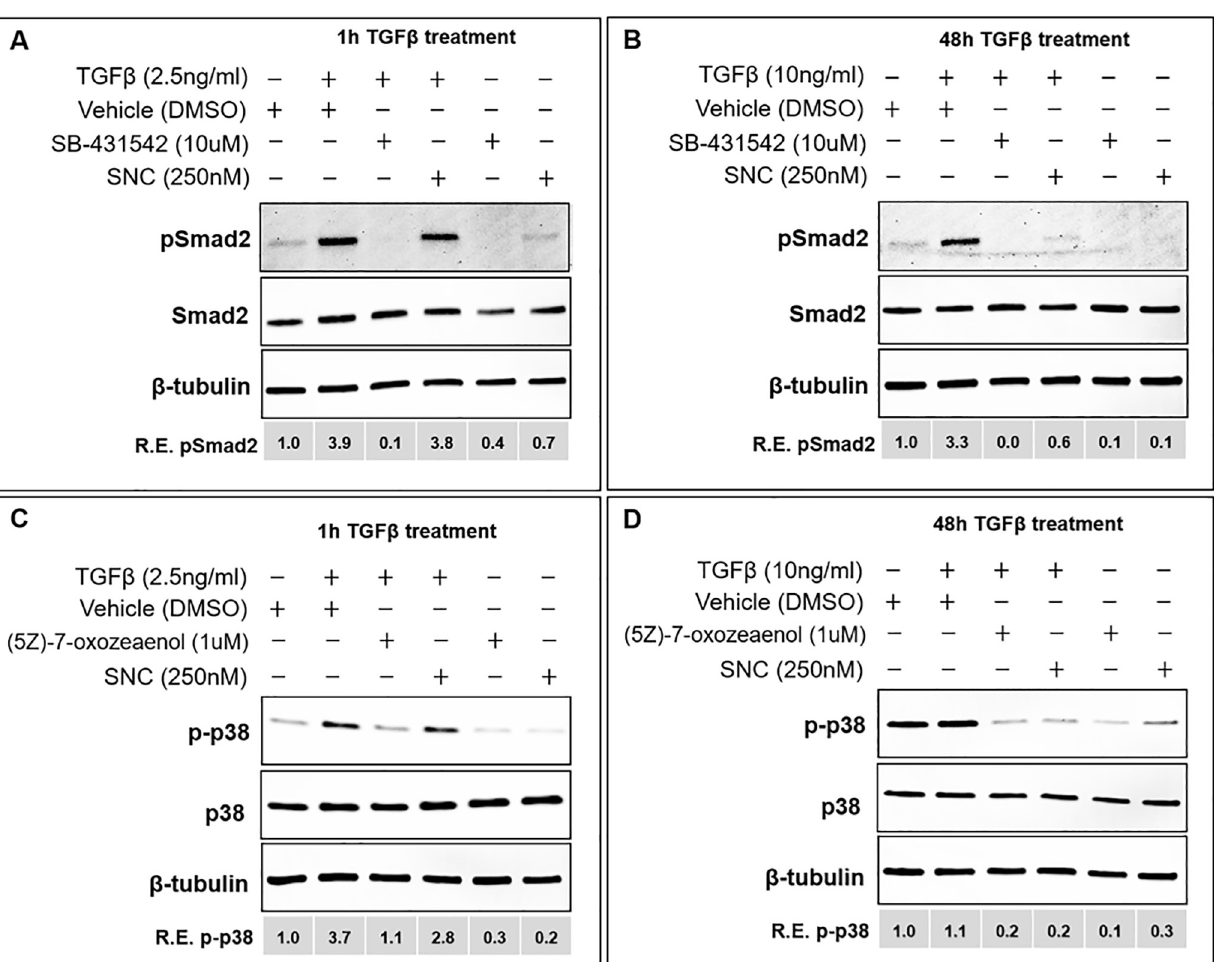
Fig 7. Inhibitors targeting canonical and non-canonical TGF β signaling show that SNC first targets TAK/p38 signaling and then indirectly Smad signaling. Cells were plated at a density of 10,000 cells/cm 2 in 10% FBS media for 24 hours, then starved in 0.1% FBS media for 18 hours. Cells were incubated in vehicle, SNC or inhibitor for 1 hour prior to TGF β stimulation for 1 hour or 48 hours. A) Smad signaling was affected after 1h TGF β stimulation in cells treated with the Smad inhibitor SB-431542 but not SNC. B) After 48 hours, cells treated with TGF β in the presence of both SB-431542 and SNC showed decreased Smad signaling. C) TAK signaling was affected both after 1 hour (C) and 48 hours (D) in cells treated with either the TAK inhibitor (5Z)-7-oxozeaenol or SNC upon TGF β stimulation. Experiments were performed independently at least two times; similar trends in protein expression were reproducible at different cell passages. Representative western blots are